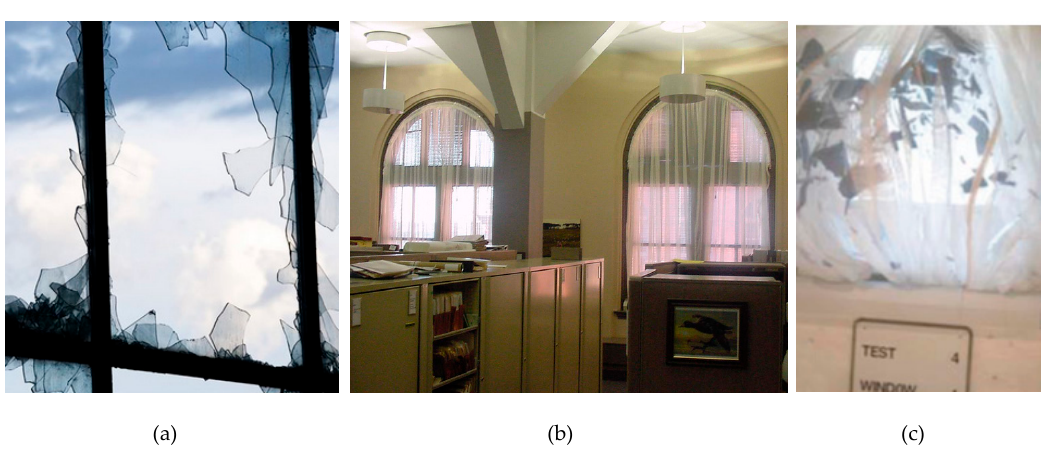
Figure 14. Glass windows and facades under shock: ( a ) example of severe damage of un-protected window and ( b )-( c ) enhanced performance in presence of textile curtain nets. Experimental and FE numerical investigations were carried out by several researchers, in the last years, to explore the potential and feasibility of these textile curtains, so that they could be efficiently used as a passive protection device for glass facades, see [88–93]. Careful consideration was spent, in [89,91], for the assessment of major effects and failure process of woven fabric drapes (Twaron® plain weave samples), under ballistic impact (0.22 calibre bullet projectiles with spherical tip), see Figure 15.